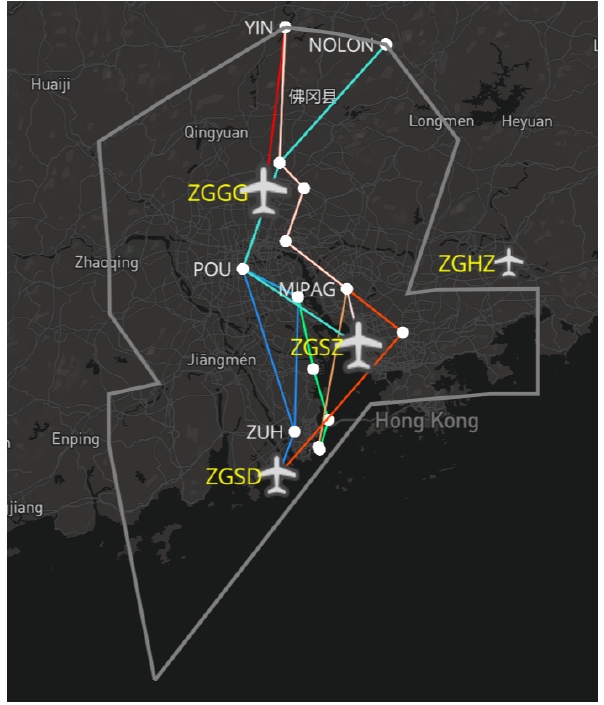
Figure 6. Location of airports in Guangdong–Hong Kong–Macao Greater Bay